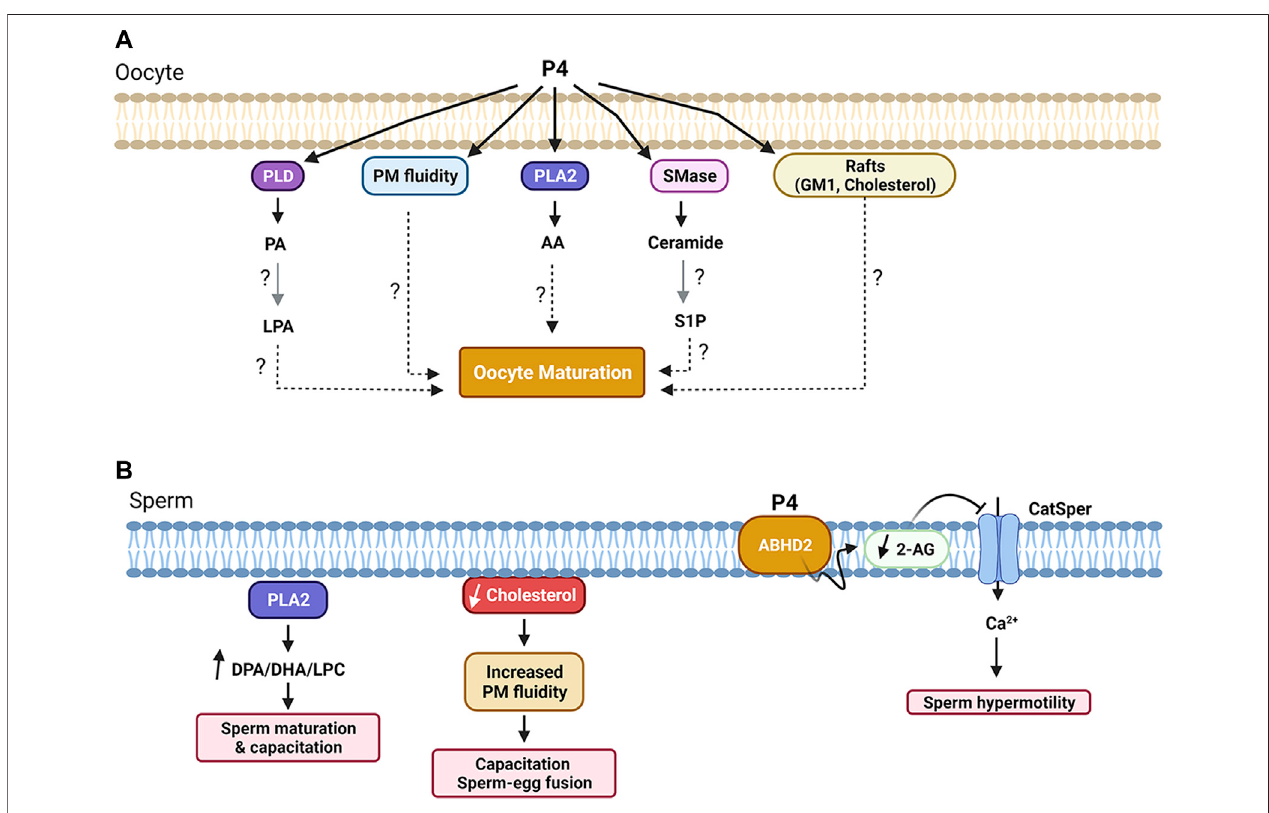
FIGURE 3 | Summary of lipid-dependent signaling during oocyte (A) and sperm (B) maturation. See text for details. Figure created with BioRender.com.